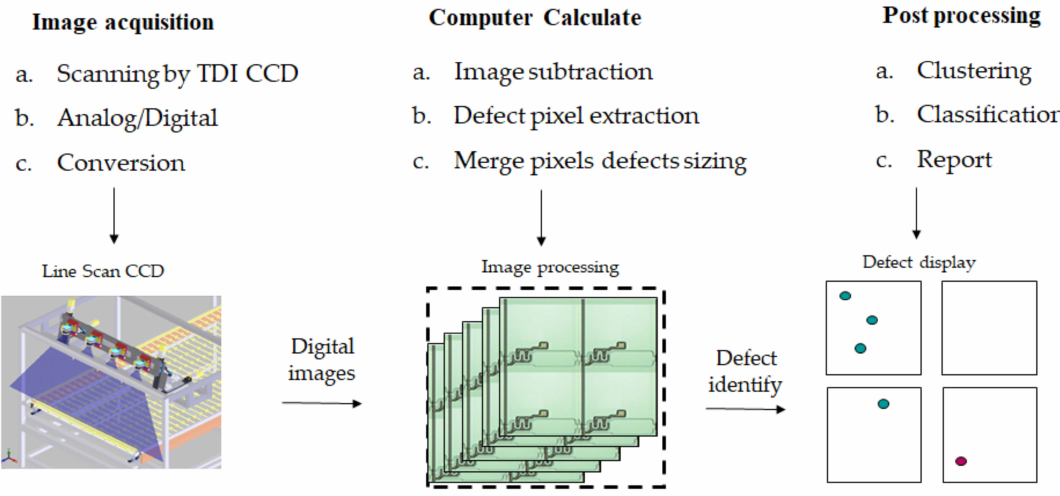
Figure 2. A process of an image extracted by automatic optical inspection.